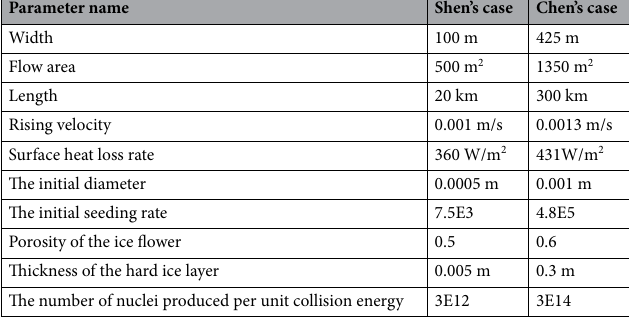
Table 1. Initial condition of Shen’s 46 case and Chen’s 41